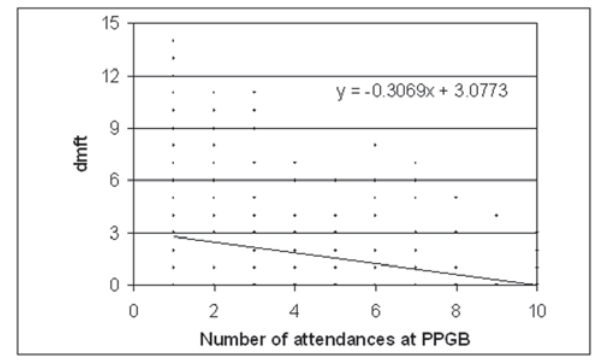
FIGURE 2- Projection of the number of appointments kept and dmf index. If the number of attendances by the Preventive Program for Pregnant Mothers and Babies were 10 times, the dmf index would be zero. Federal University of Piauí, 2005